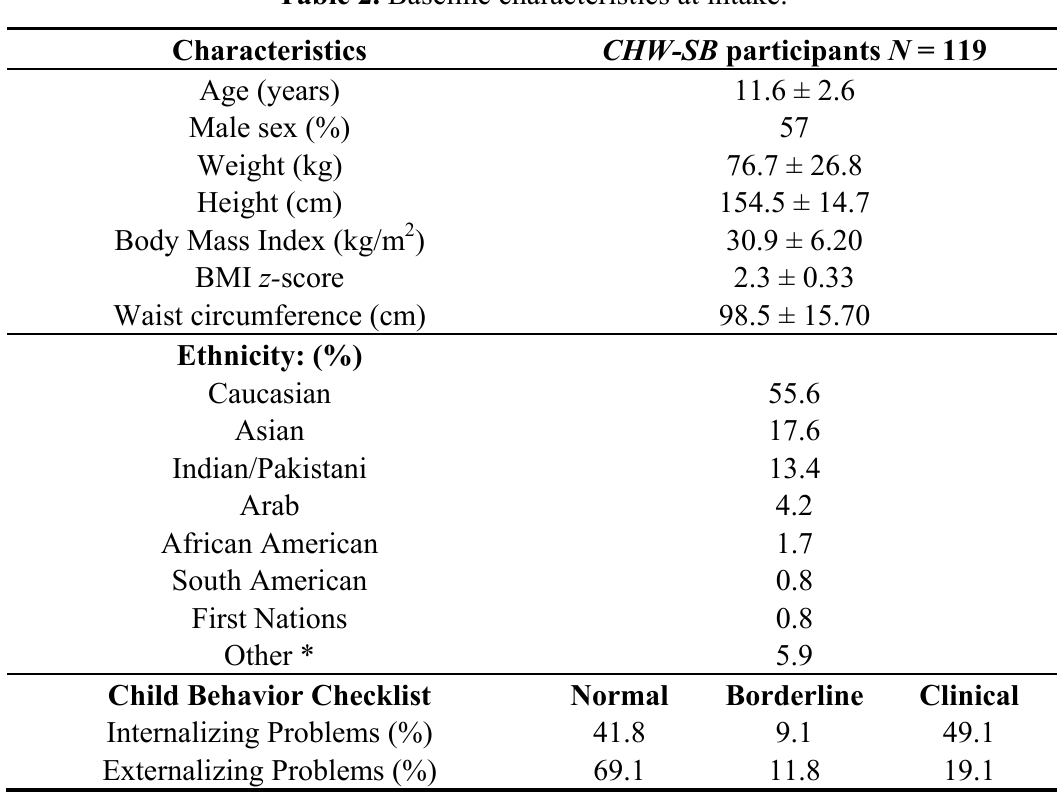
Table 2. Baseline characteristics at intake.